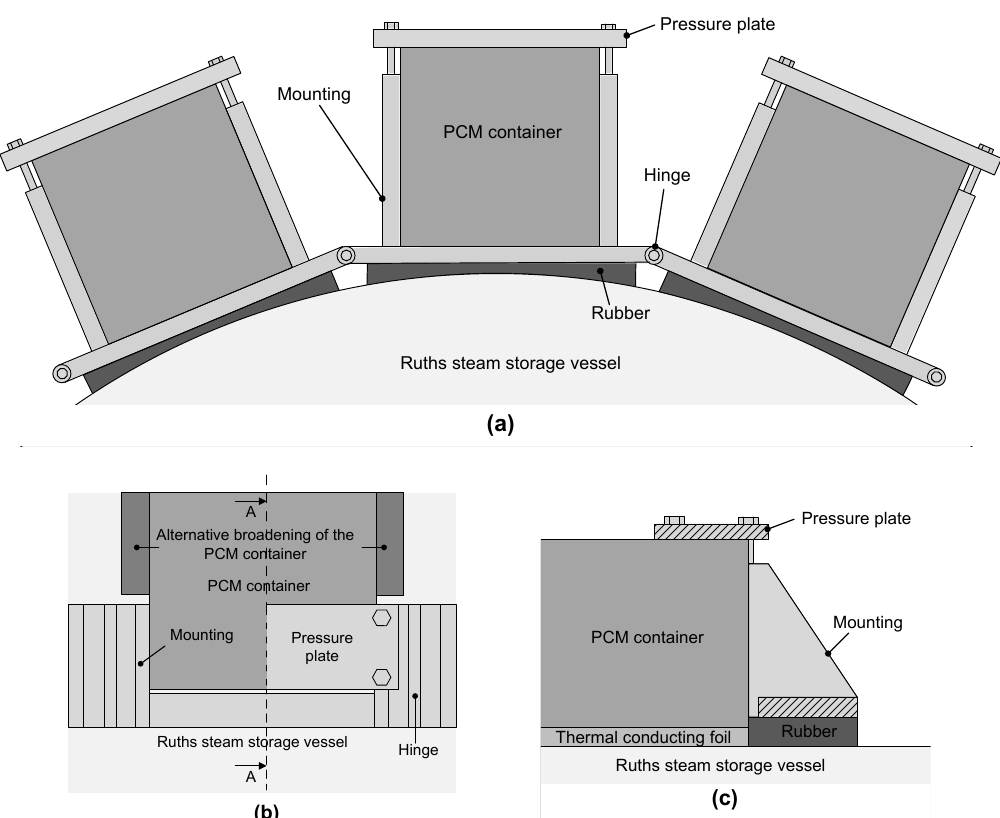
Figure 7. Schematic sketch of the PCM container mounting: ( a ) front view. ( b ) top view. ( c ) sectional view A-A. According to